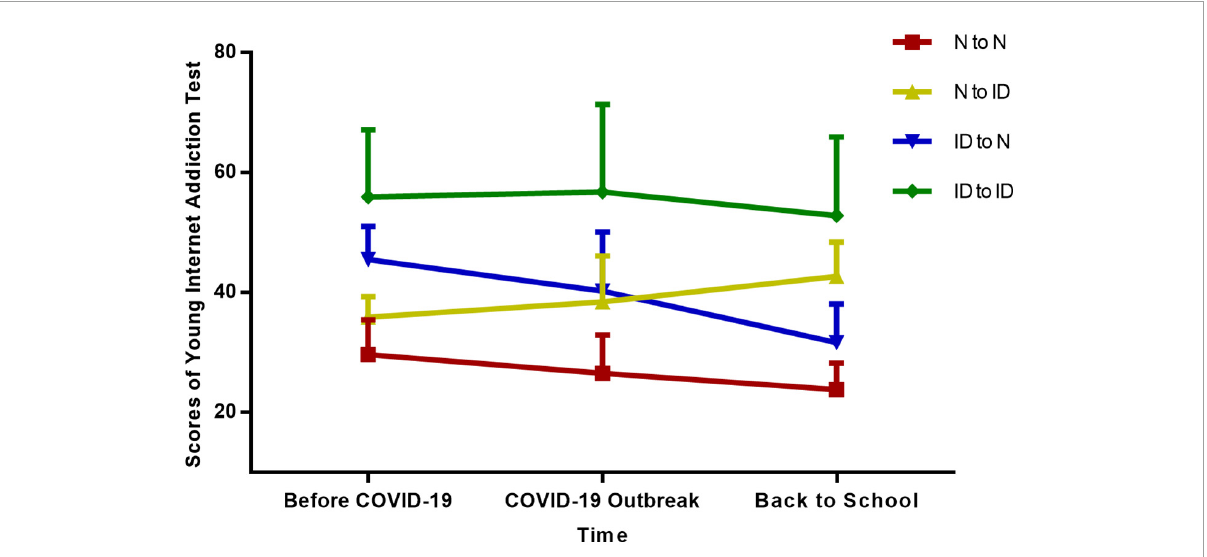
FIGURE1 Changes of Young’s Internet Addiction Test scores of adolescents in different Internet behavior changing groups. N to N = Continuous Normal Group; N to ID = From Normal to Internet Addiction Group; ID to N = From Internet Addiction to Normal Group; ID to ID = Continuous Internet Addiction Group. Before COVID-19 (T1) = before Dec 1, 2019; COVID-19 Outbreak (T2) (in China) = Jan 1, 2020 to March 31, 2020; Back to School (T3) (in China) = after April 1/2020.